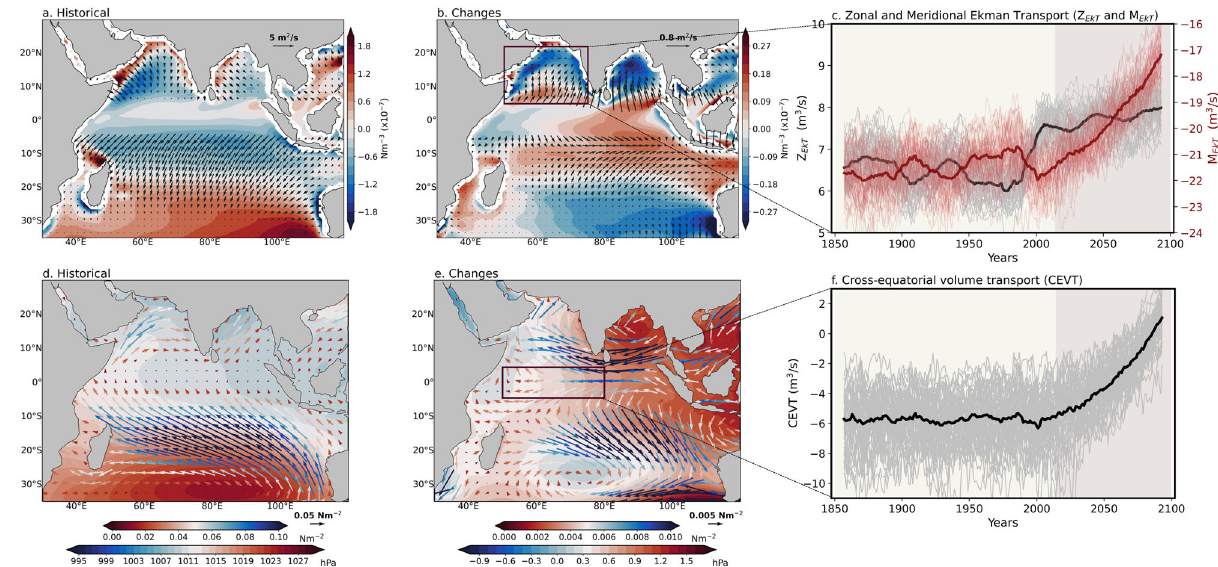
Fig. 4 | Drivers for future changes in forced warming pattern over Arabian Sea (AS). Left panel shows the ensemble mean climatology of a wind stress curl (sha- ded) and Ekman transport (vectors), and d mean sea level pressure (shaded) and surfacewindstress(vectors)forthe50membersofCESM2-LEduringthehistorical period (1980 – 2000). b , e Same as in ( a , d ) but for the ensemble mean changes by taking the difference between the future (2080 – 2100) and the historical (1980 – 2000) periods. The right panel shows area-averaged time series of